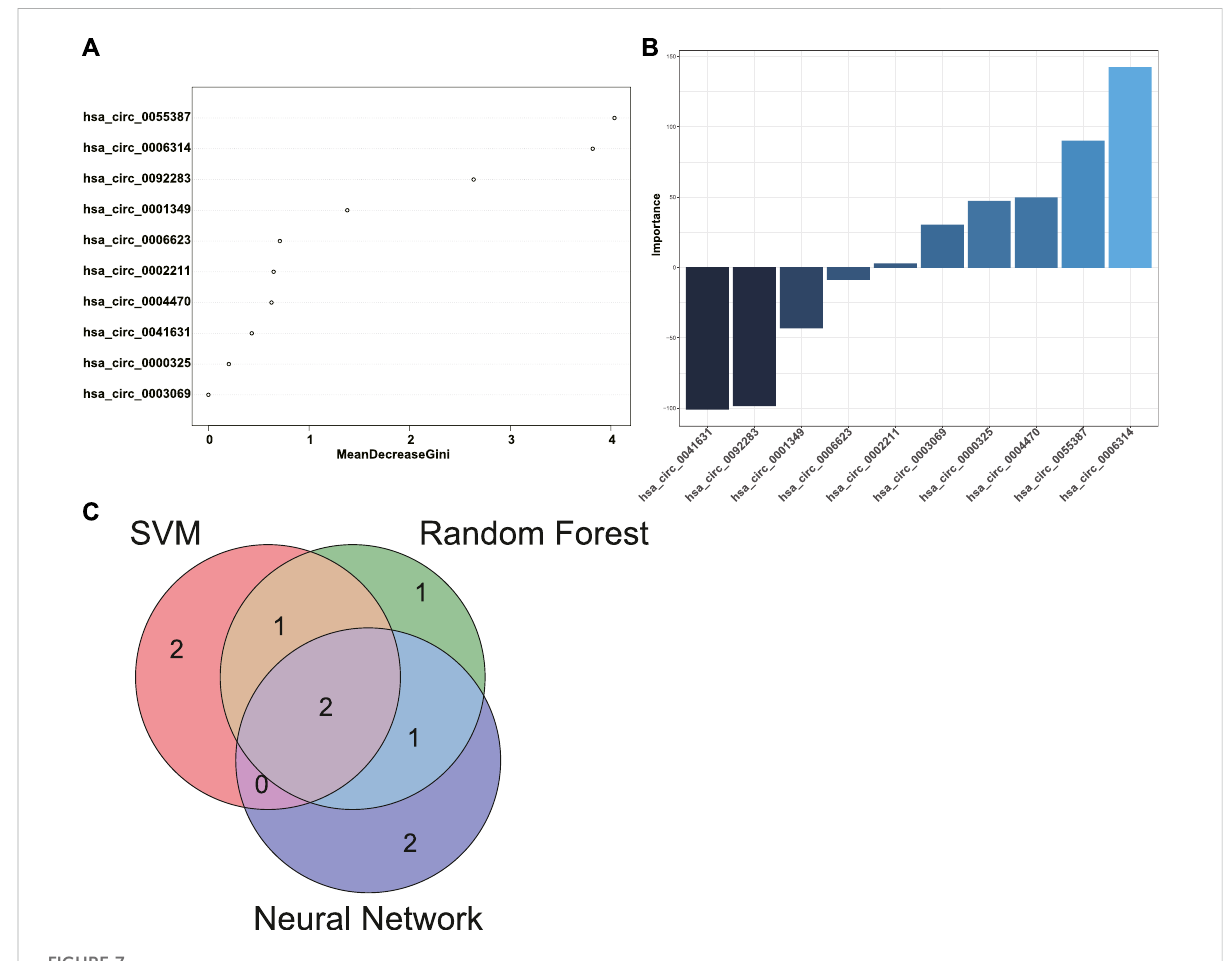
FIGURE 7 Identi fi cationofbiomarkersforPOAF. (A) Therankoffeatureimportance inRFpredictivemodelforPOAF. (B) Therankoffeatureimportancein neural network predictive model for POAF. (C) The intersection between top fi ve features of each model was shown in the Venn diagram. POAF: postoperative atrial fi brillation, RF: random